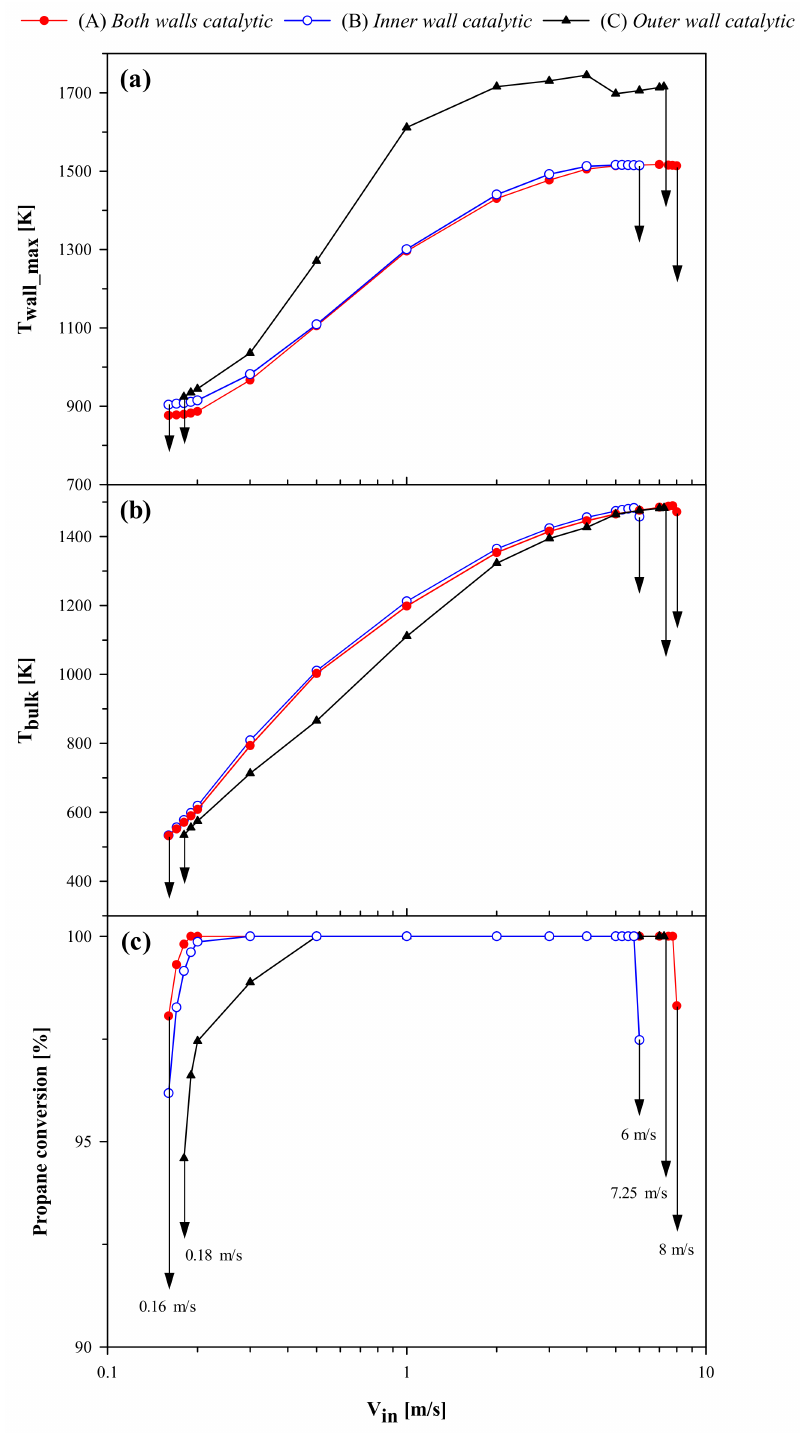
Figure 4. ( a ) Maximum wall temperature, T wall_max ; ( b ) bulk gas temperature at outlet, T bulk ; and ( c ) propane conversion at outlet versus V in for the three reactor configurations of Figure 1 with different catalyst placement. Low thermal conductivity (3 W/(m K)). Arrows indicate extinction (at low values of V in ) and blowout (at high values of V in